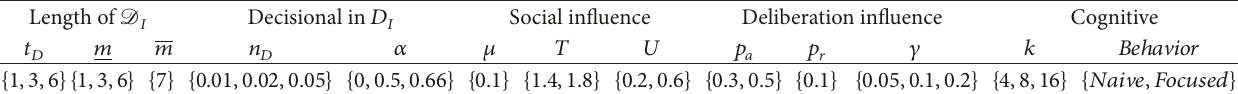
Table 1: Parameters and parameter types and their domains used to compare dyadic, collective, and mixed opinion dynamics. Length of D